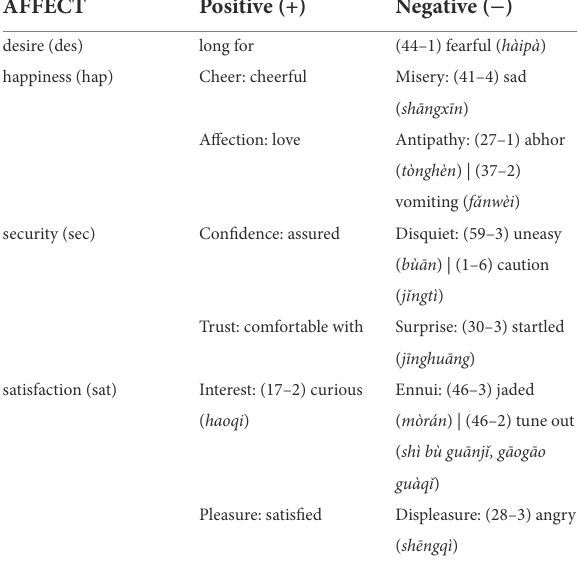
TABLE 1 Categories of affect 1 .